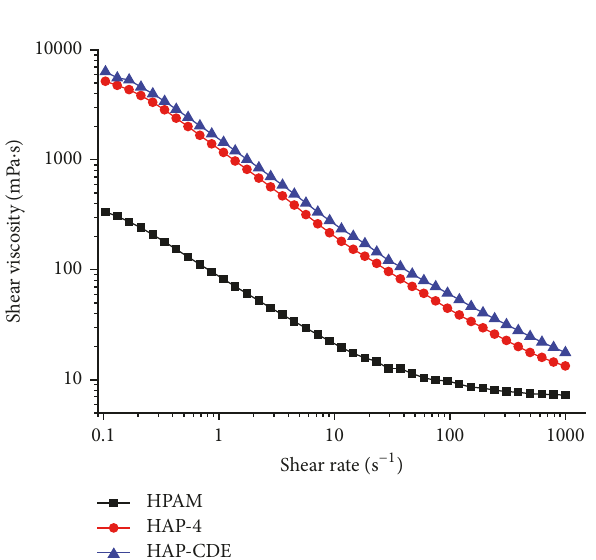
Figure 2: Experimental setup for sand pack test experiments.